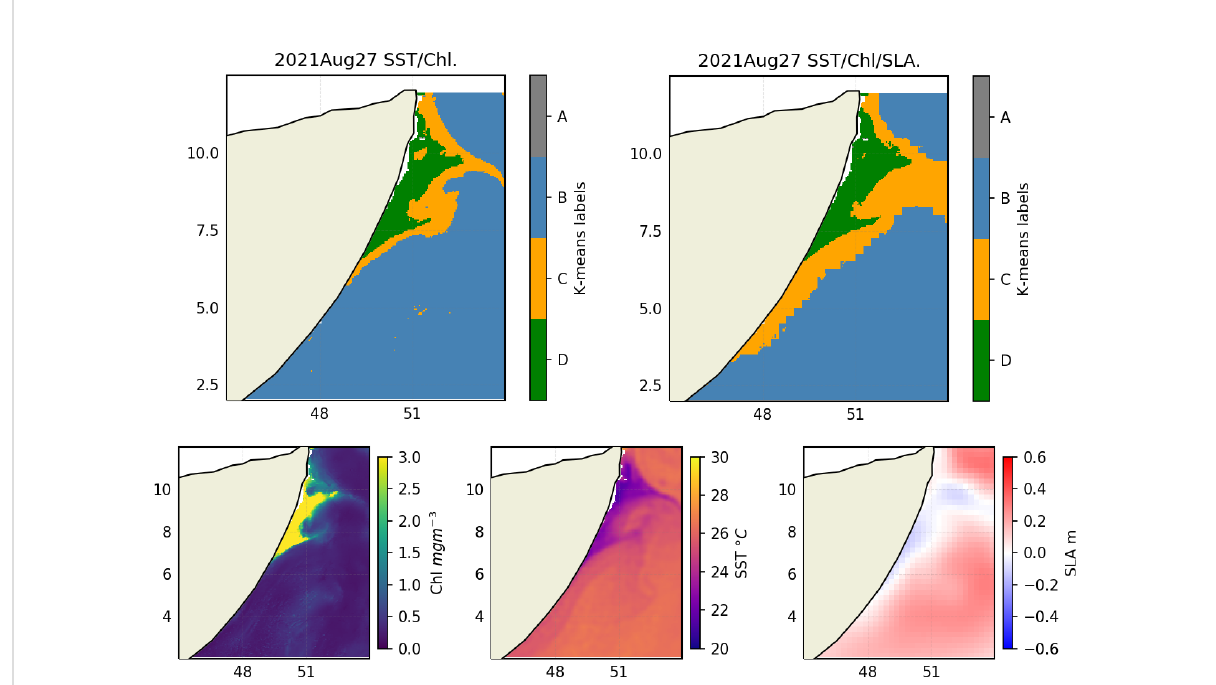
FIGURE 8 Example of image showing one day of the two clustering models. (Top left) clustering using Chl and SST only, (top right) clustering using Chl, SST, and SLA. The bottom row shows the three underlying variables: Chl (bottom left), SST (bottom centre), and SLA (bottom right).